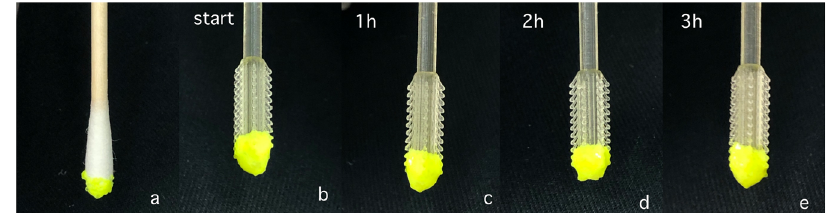
Fig. 9 PCR compatibility test. a Result for a normal cotton swab dipped into target mucus. b Result of a 3D-printed swab dipped into target mucus. c 3D-printed swab after 1 h. d 3D-printed swab after 2 h. e 3D-printed swab after 3